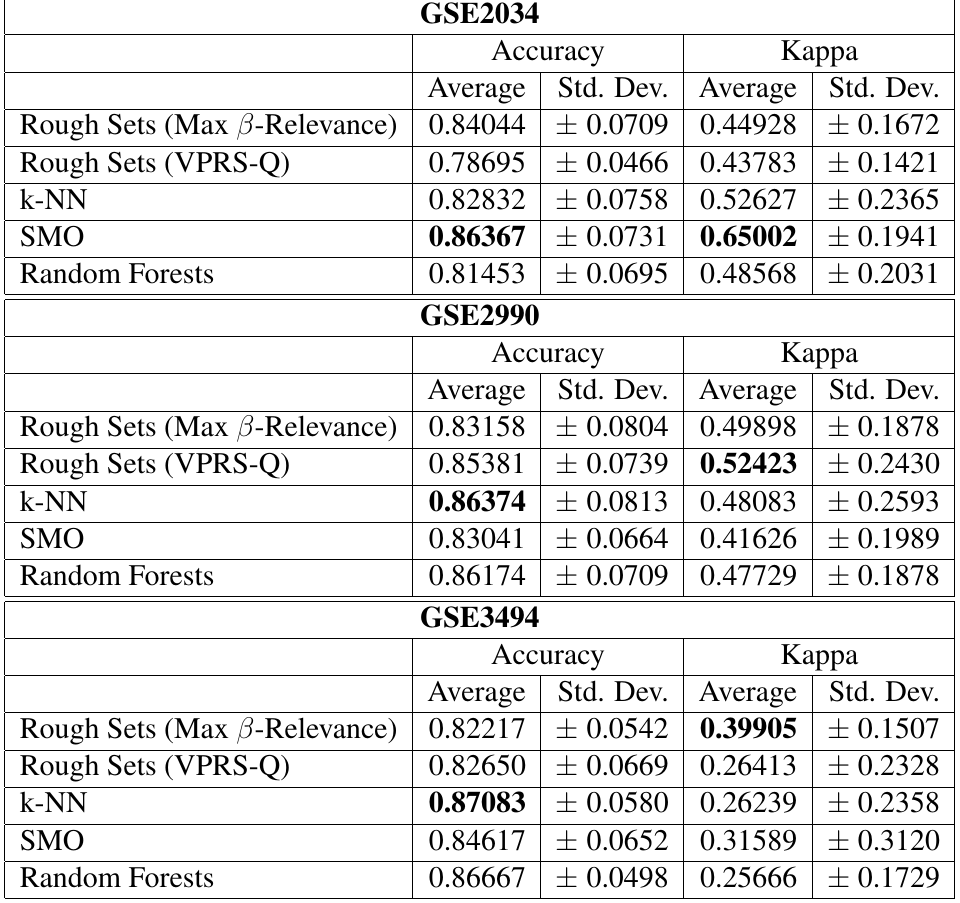
Table 1: Accuracy and kappa of classifications